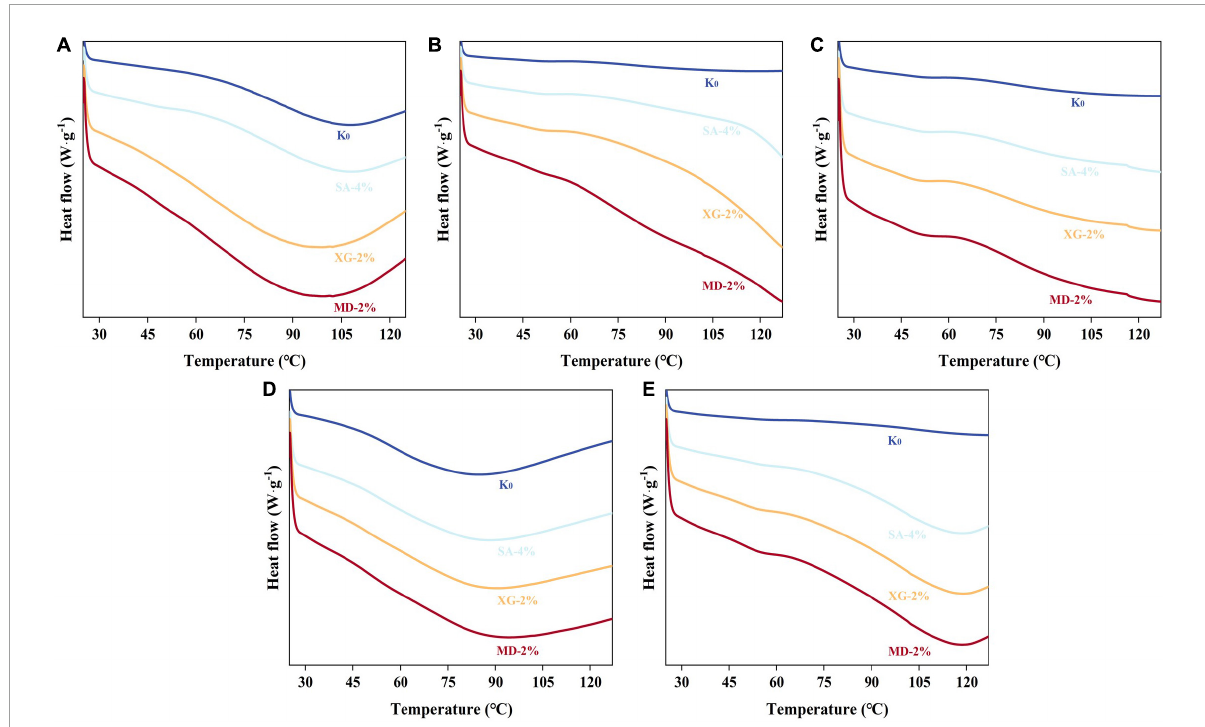
FIGURE6 Differential scanning calorimetry characteristics of extrudates in different zones. (A) Mixing zone, (B) Heating zone, (C) Melting zone, (D) Die zone, and (E) Cooling zone.